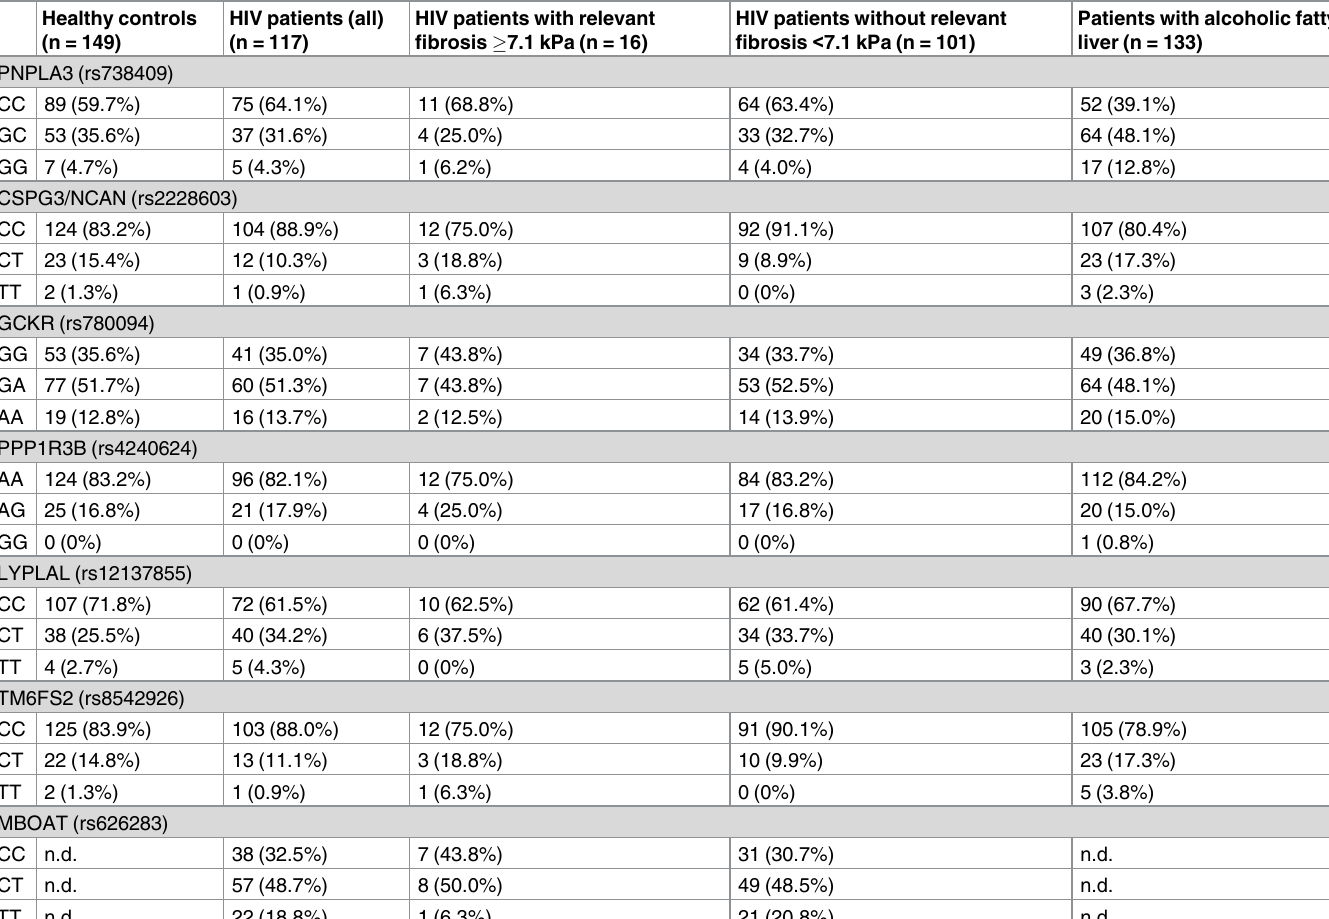
Table 3. SNPs allele distribution in HIV positive patients, HIV positive patients with fibrosis, healthy controls and alcoholic fatty